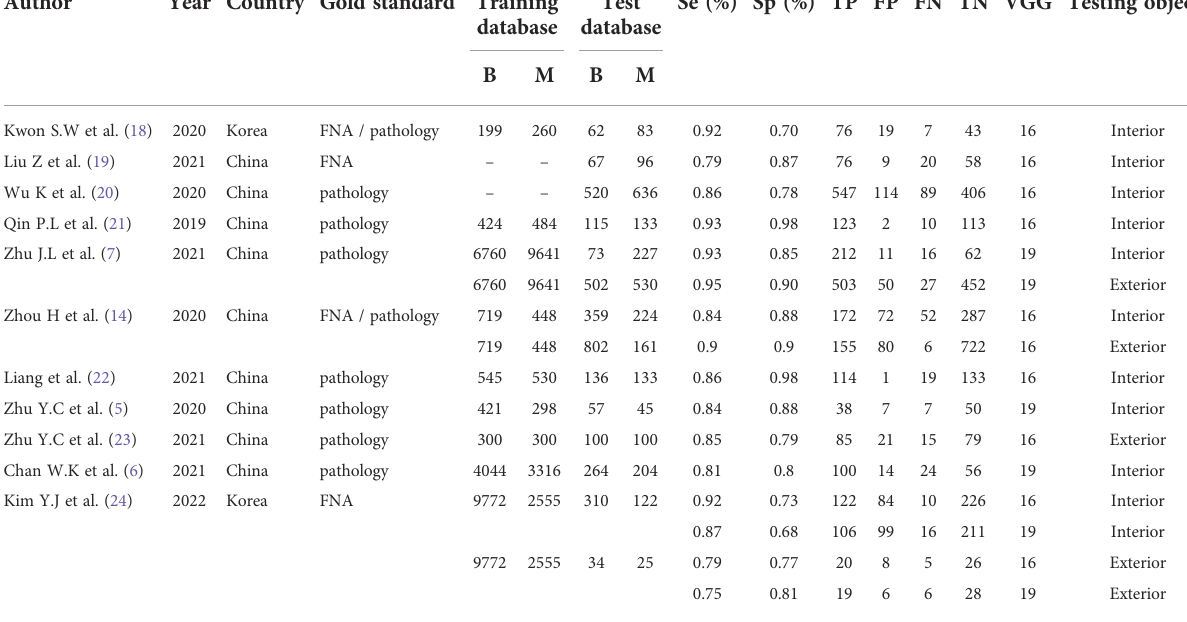
TABLE 1 Characteristics of the included